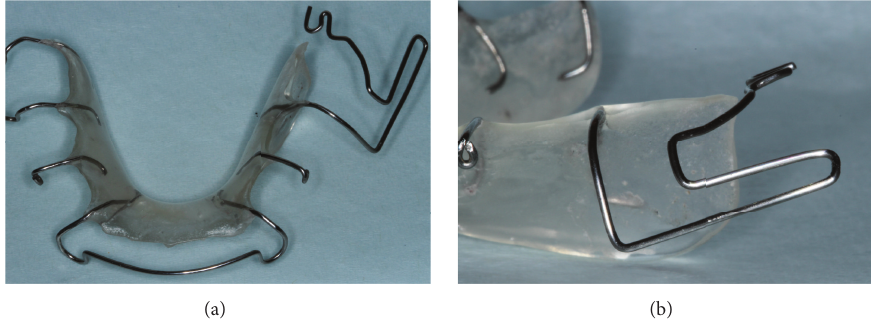
Figure 2: A sample removable appliance explaining T-loop: (a) occlusal view, (b) left view.